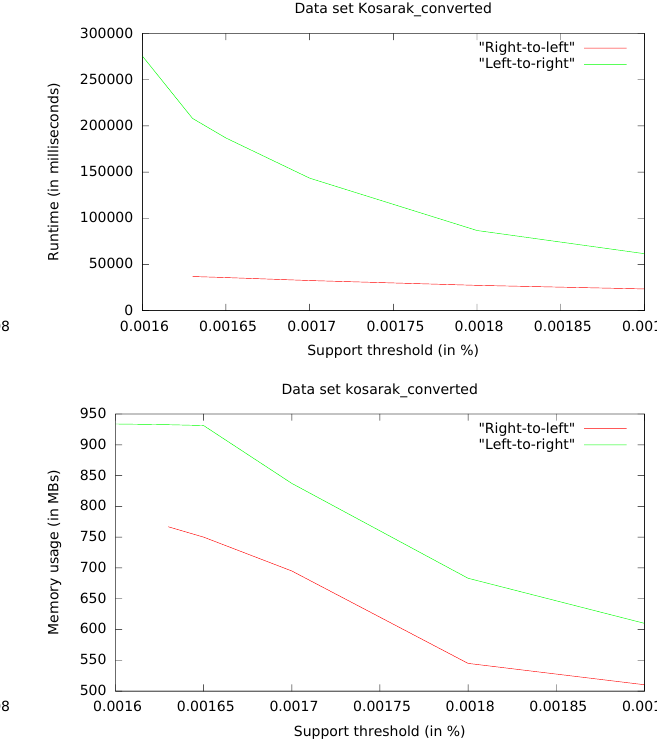
Figure 1. Performances of left-to-right and right-to-left pattern- growth orderings on the real-life data set LEVIATHAN. The left- to-right pattern-growth ordering is 1 . 27 − 1 . 4 times faster, and requires less memory if the support threshold is less than 0 . 05 and a little more memory otherwise.